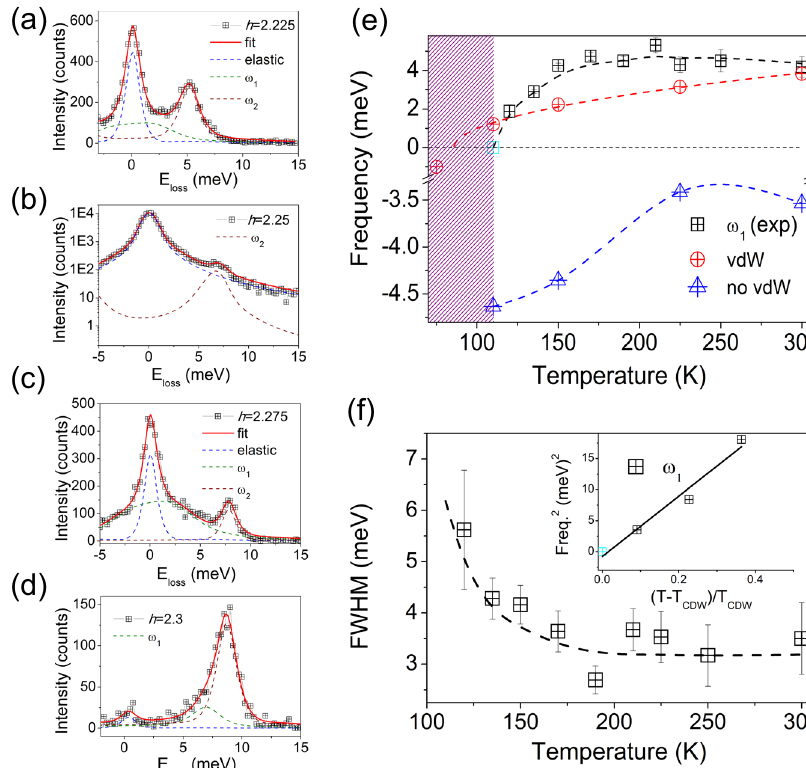
Fig. 3 Phonon collapse and van der Waals melting. a – d Representative IXS spectra at 110 K and their corresponding fi tting. The IXS scan at h = 2.25 r.l.u. is presented in logarithmic scale due to the large enhancement of the elastic line. ω 1 stands for the soft mode. e Temperature dependence of the energy of the ω 1 branch and the anharmonic theoretical frequencies obtained with and without van der Waals corrections. The shaded area de f Temperature dependence of the linewidth. Inset, squared frequency of the soft mode as a function of the reduced temperature. Lines are guides to the eye. The cyan squares in ( e ) and ( f ) (inset) refer to the frequency of the ω 1 phonon extrapolated to the CDW temperature, since the large enhancement of the elastic line precludes the extraction of its energy from the fi tting analysis. The error bars in the experimental data points in panel ( e ) and ( f ) represent the fi t uncertainty.